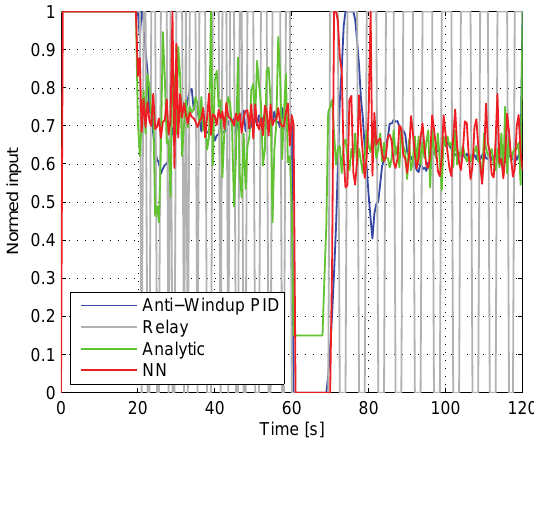
Fig. 7. Comparison results: control